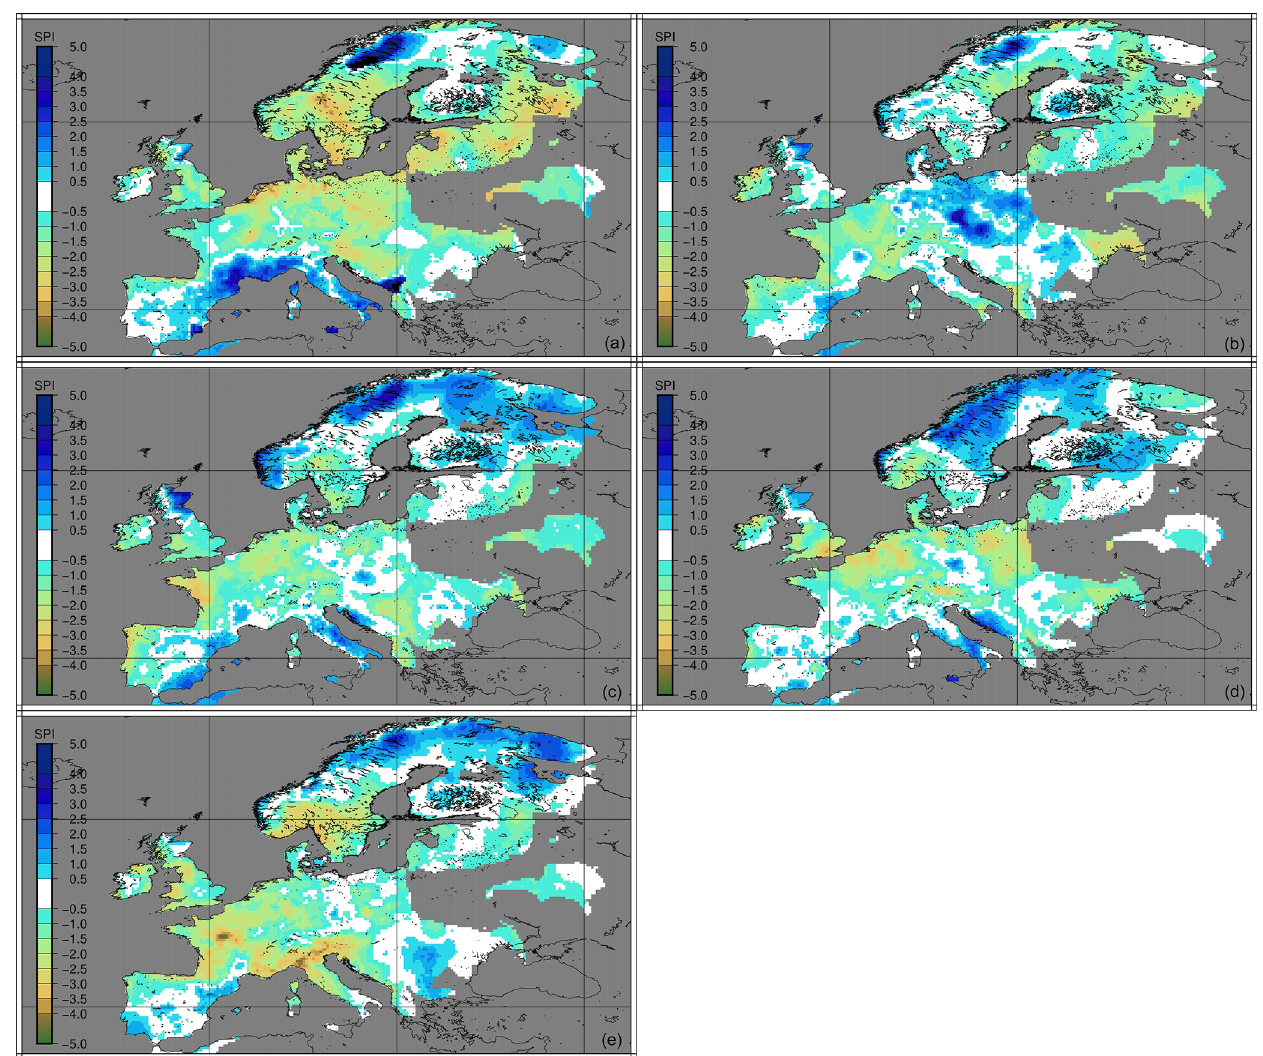
Figure 6. Maps with SPI values showing the evolution of the drought from autumn 1920 to autumn 1921. The panels show SPI3 values for September–November 1920 (a) , December–February 1921 (b) , March–May 1921 (c) , June–August 1921 (d) and September–November 1921 (e) . Maps based on the E-OBS